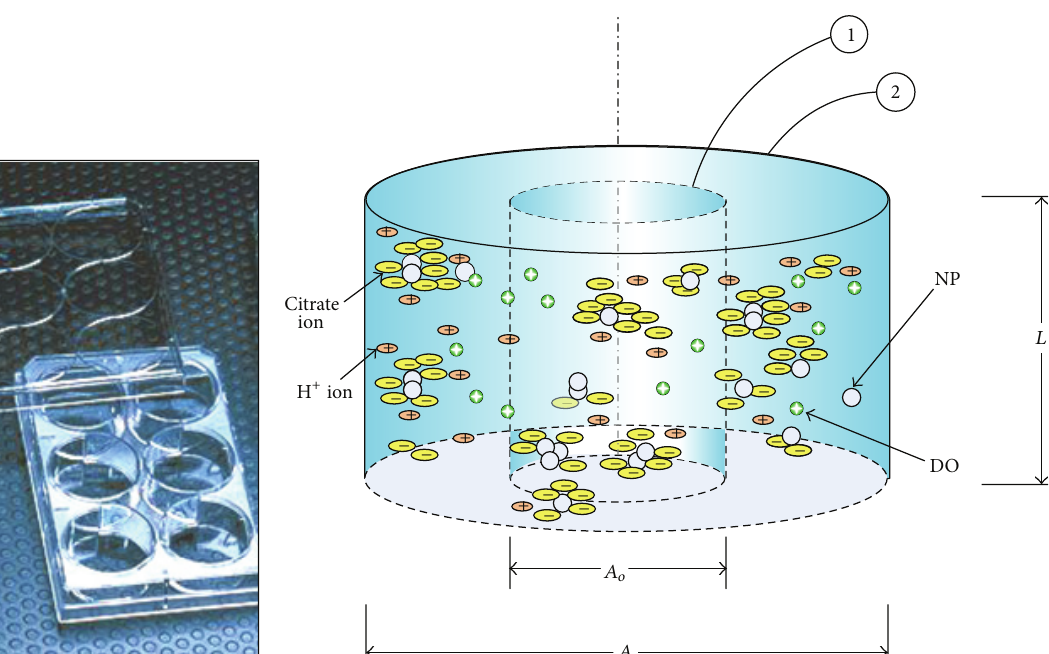
Figure 4: Schematic showing the implementation of the ADSRM for citrate-stabilized nAg in an in vitro culture well, with the control volume and the actual well shown as 1 and 2, respectively, along with an actual image (inset) of a Falcon 6-well plate used for in vitro measurements (figure reproduced from Mukherjee et al. [18] with permission) (diagram is not drawn to scale and is representative only).